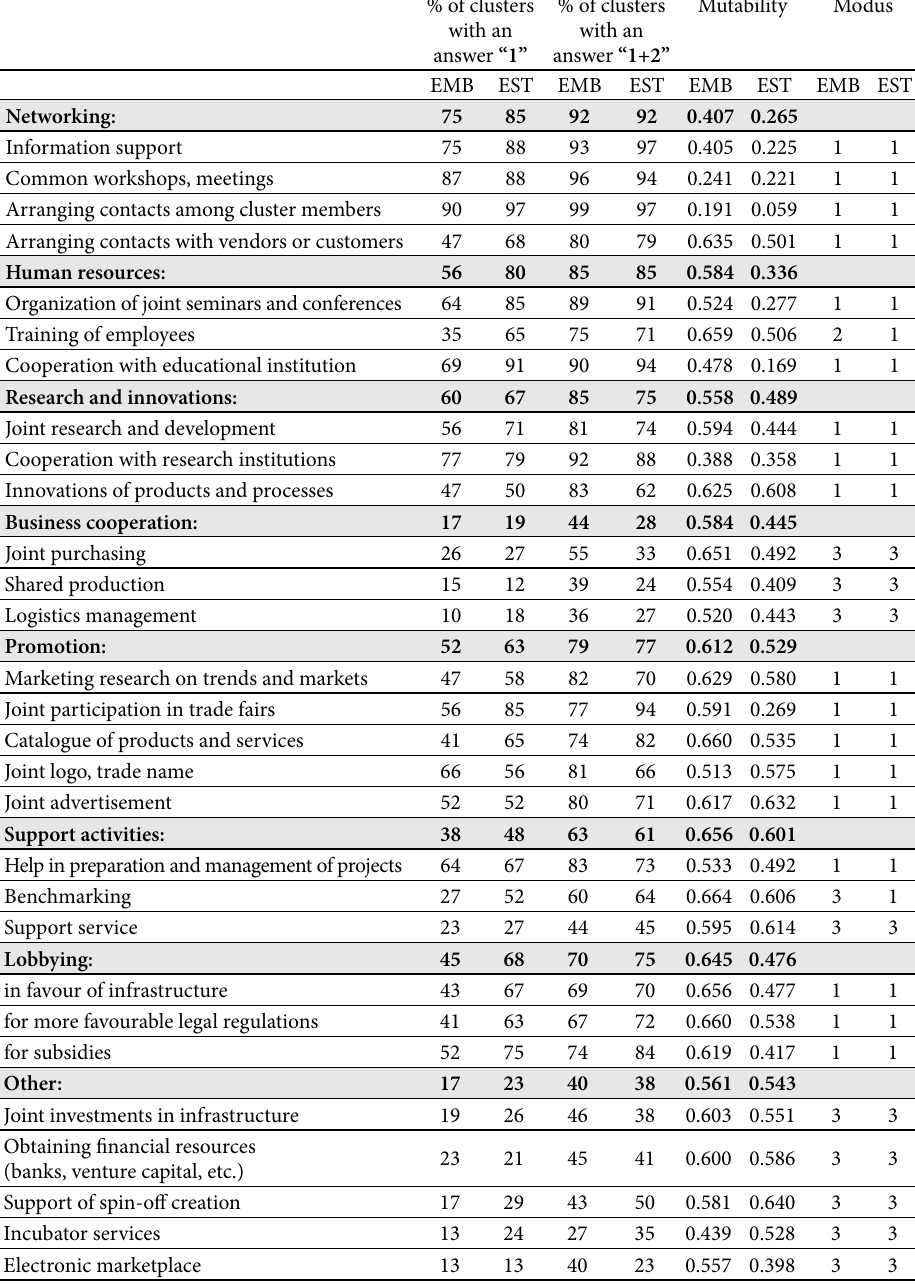
Table 2. Evaluation of implementation of activities depending on the age of clusters